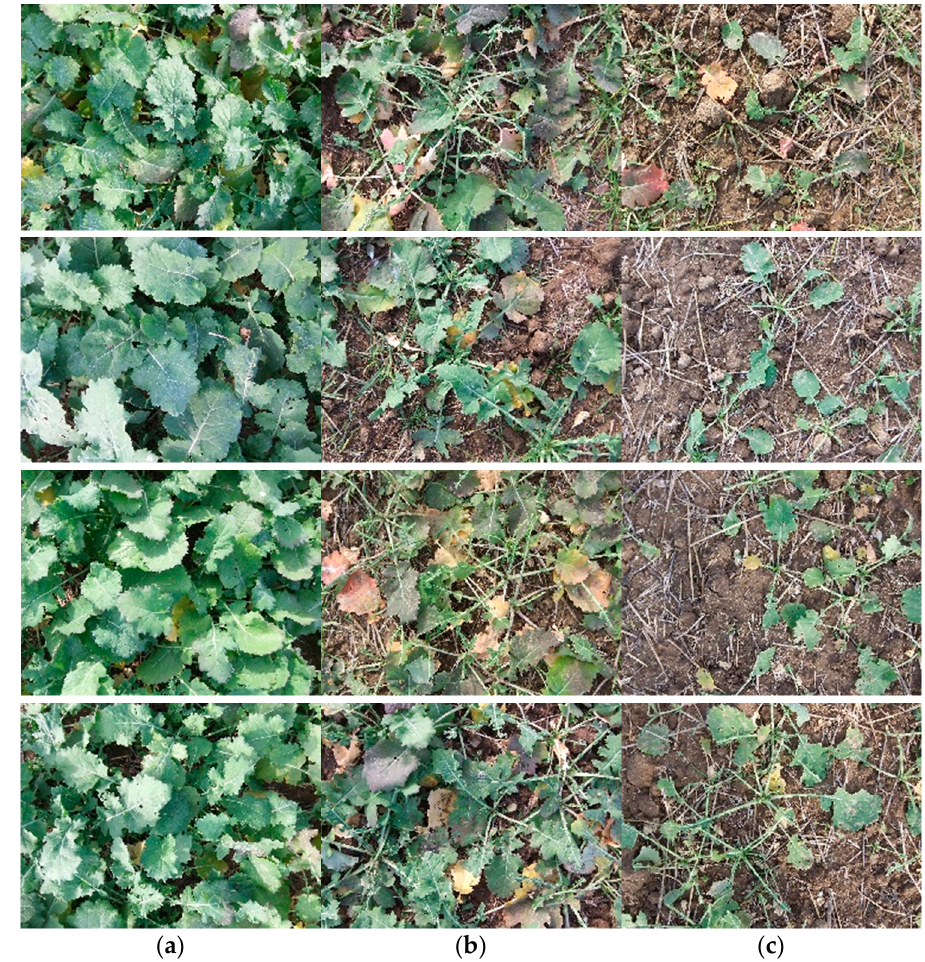
Figure 3. Some samples of rapeseed crop images in three categories; ( a ) undamaged, ( b ) partially damaged and ( c ) fully damaged crop.